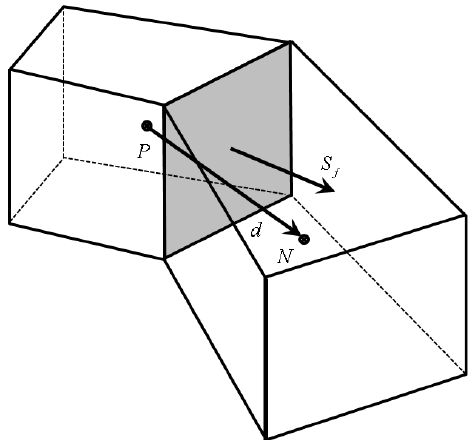
Figure A1. Sketch of two adjacent cells P and N and the shared face f owned by cell P . S f is the face surface normal vector while d denotes the distance vector from cell center P to cell center N